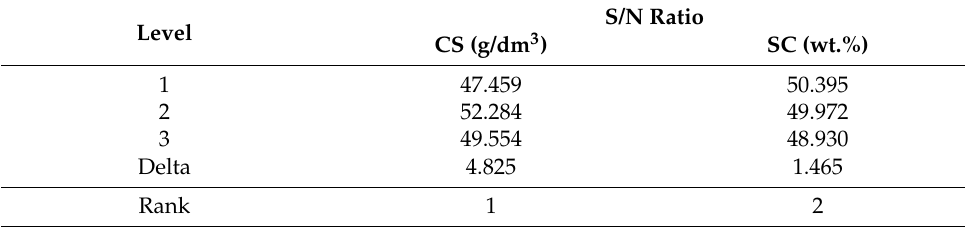
Table 5. S/N ratios of SNP by parameter level (LB).